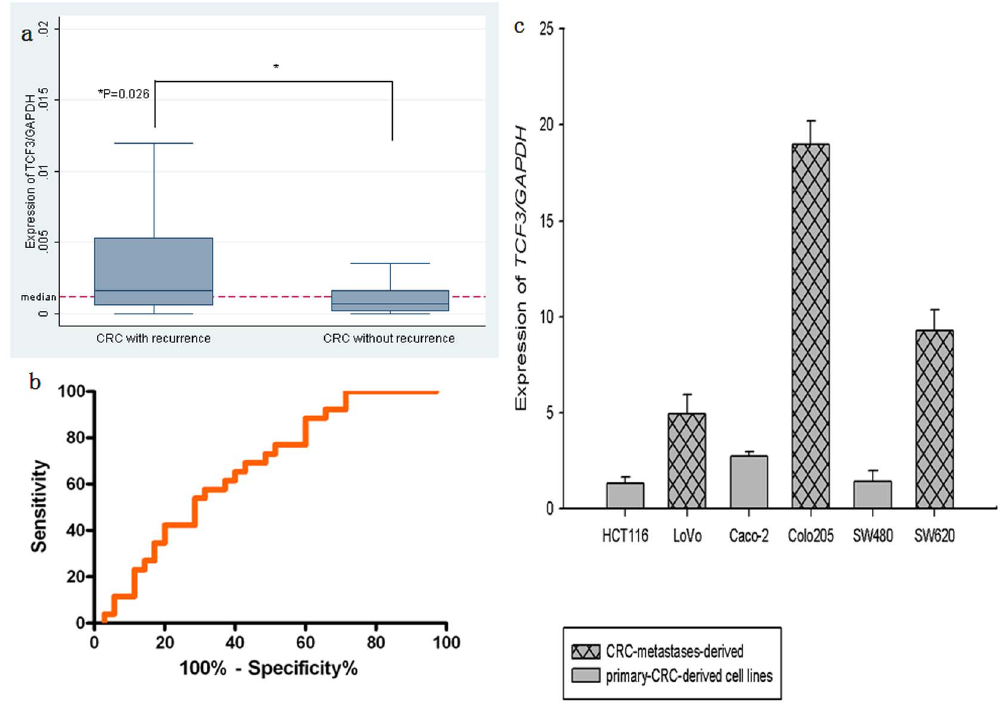
Figure 1. Expression of TCF3 in 64 CRC samples. (a) In recurrent CRC, TCF3 mRNA levels were significantly increased comared to the CRC without recurrence (Wilcoxon Signed Ranks Test, P , 0.05). (b) ROC curve showing the performance of TCF3 in predicting recurrence of CRC. Area under curve (AUC) =0.668 (95% CI 0.534–0.803), P value =0.012. (c) TCF3 mRNA levels were measured with qPCR in 6 CRC cell lines. GAPDH signals were used as a relative measure of the expression level of target genes. The representative results, conducted in triplicates, are shown as mean 6 SD.